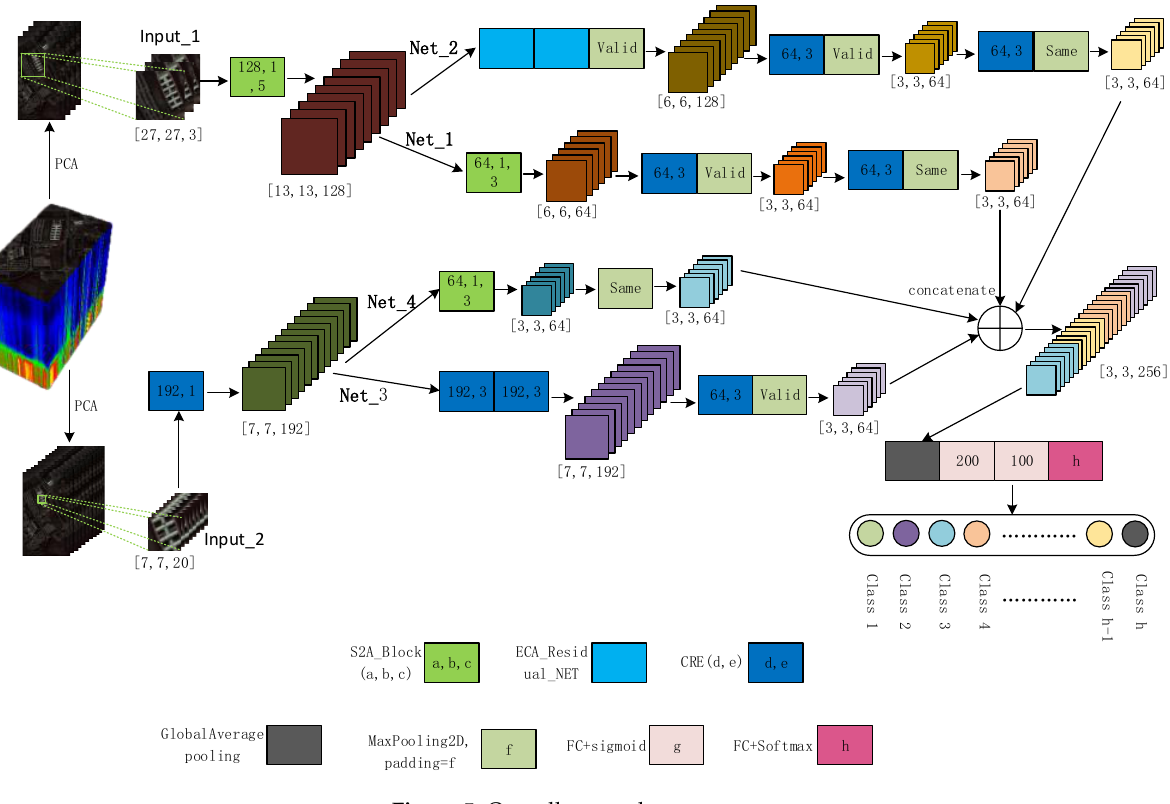
Figure 5. Overall network structure.